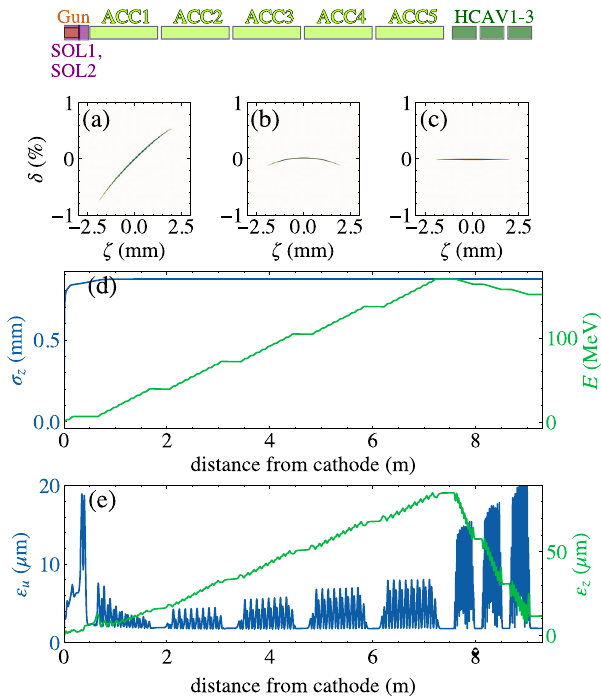
FIG. 3. Photoinjector diagram (upper schematics) and snap- shots of the LPS distribution at z ¼ 1 . 88 (a), 7.48 (b), and 9.3 m (c) from the photocathode. Evolution of the beam energy and rms bunch length (d) and corresponding 4D transverse and longi- tudinal emittances (e). In the upper block diagram, SOL1 and SOL2 refer to the solenoidal magnetic lenses, ACC1-5 is the 1.3-GHz SRF cavities, and HCAV1-3 represent the 3.9-GHz SRF cavities. In plots (a – c) and throughout this paper, ζ > 0 corre- sponds to the head of the